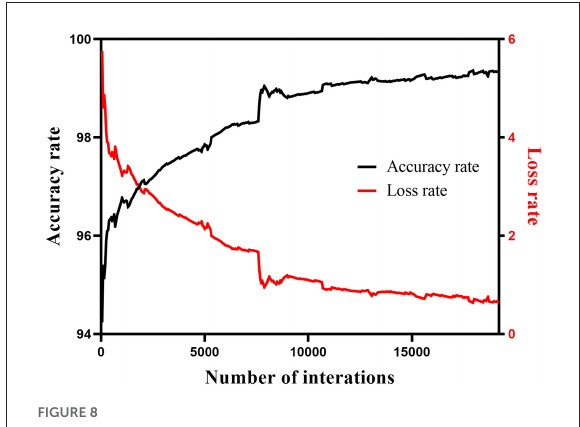
FIGURE8 Variation trend of loss rate and accuracy rate in the training process of Mask R-CNN model.